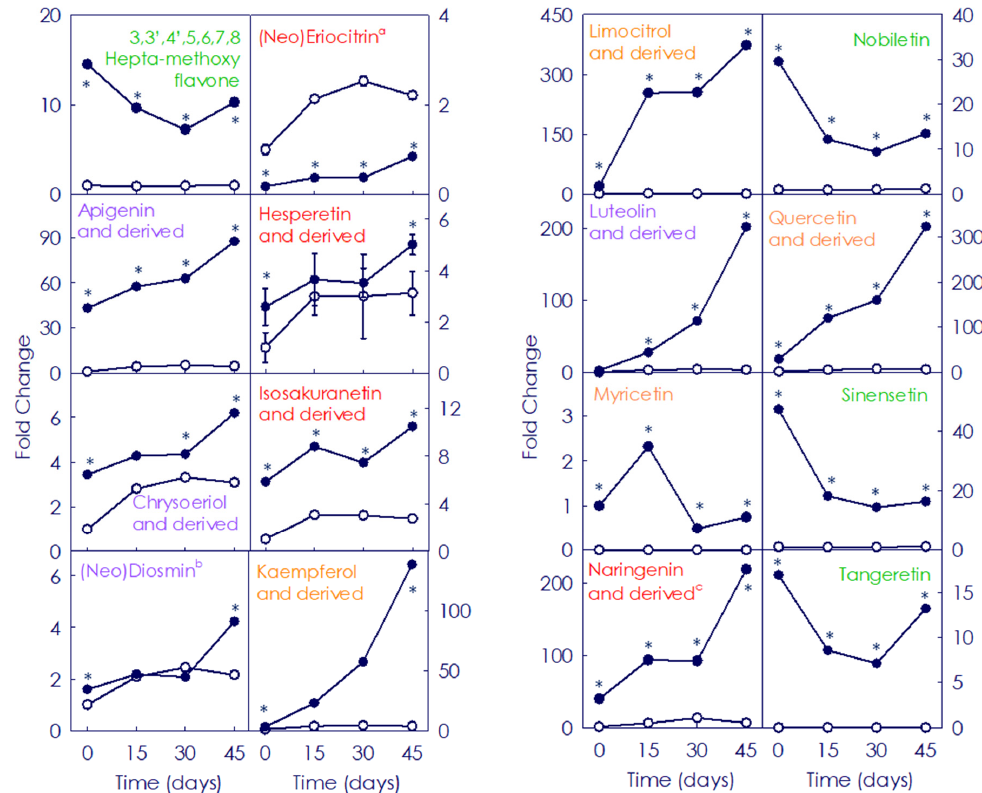
Figure 5. Fold change of representative flavonoids identified in the pulp of Moro ( ● ) and Pera ( ○ ) oranges during storage for 0, 15, 30 and 45 days. Compounds belonging to flavanones class are represented in red colour, flavonols class in orange and the flavones in purple and light green (polymethoxyflavones subgroup). a . Sum of eriocitrin and neoeriocitrin. b . Sum of diosmin and neodiosmin. c . Including the naringenin chalcone. Data are expressed as the mean fold change ± SD of each sample compared to the control Pera fruits sample (at harvest time). Asterisk indicates statistically significant different values ( p ≤ 0.01) for each given time.